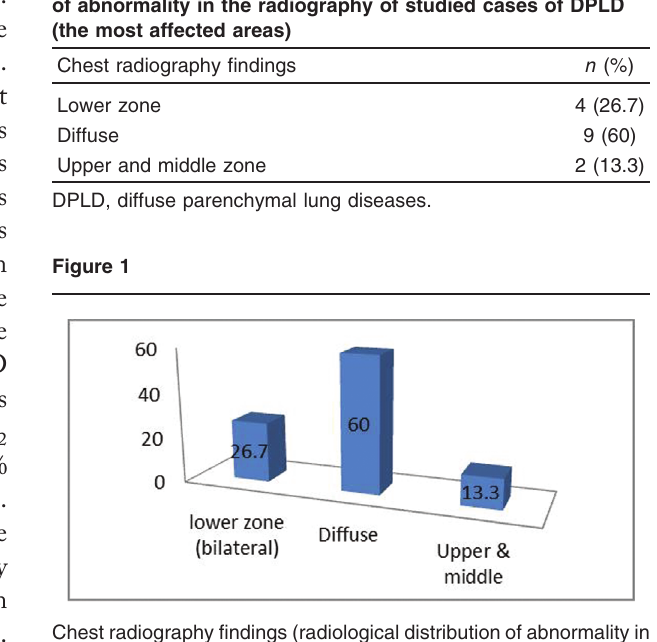
Table 1 Chest radiography findings: radiological distribution of abnormality in the radiography of studied cases of DPLD